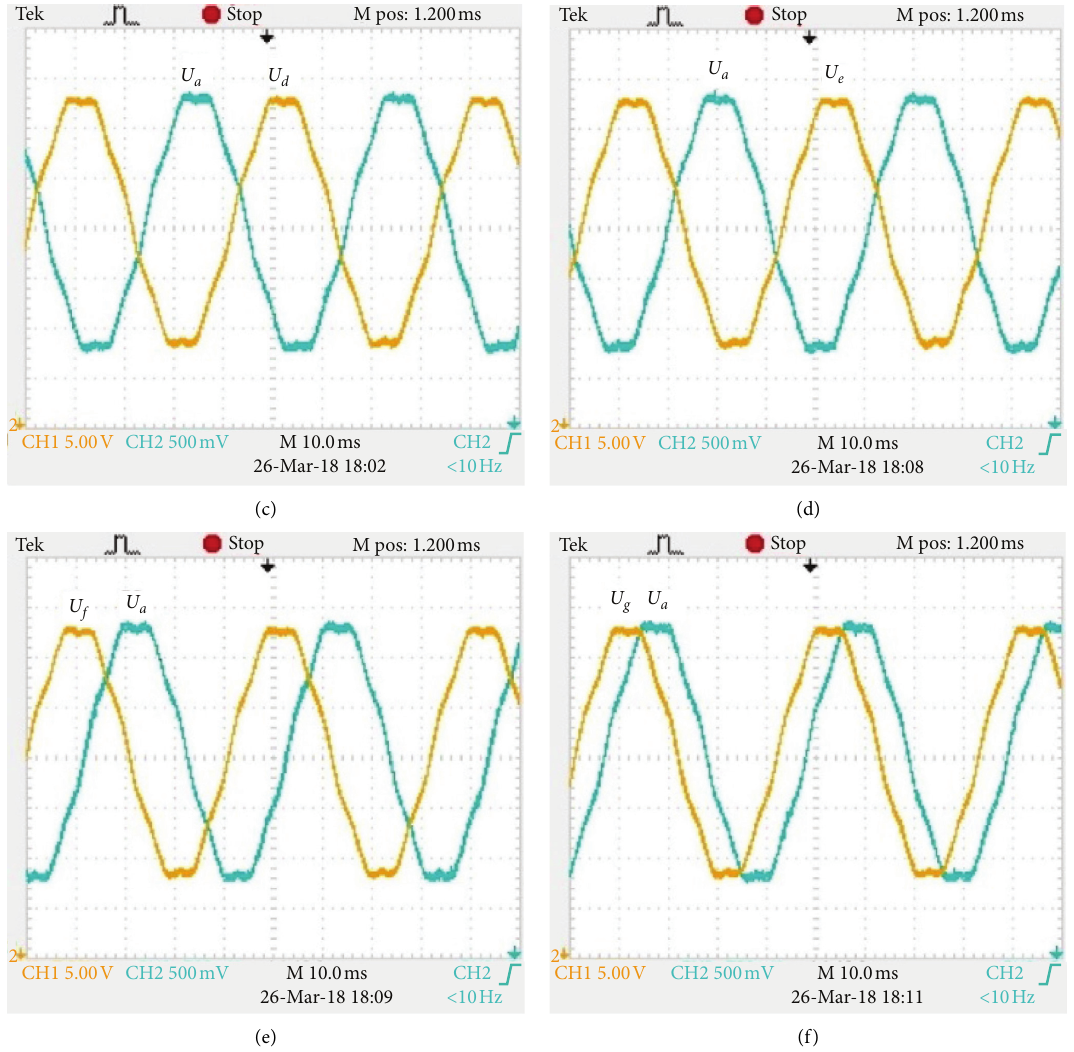
Figure 11: Phase voltage experimental waveform of NSV-SVPWM. (a) a phase and b phase voltage (b) a phase and c phase voltage, (c) a phase and d phase voltage, (d) a phase and e phase voltage, (e) a phase and f phase voltage, (f) a phase and g phase voltage.